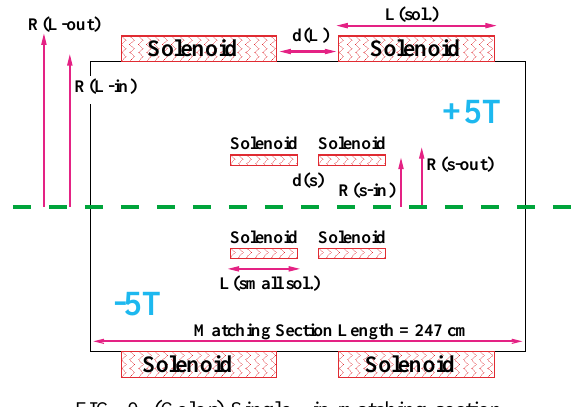
FIG. 9. (Color) Single flip matching section.